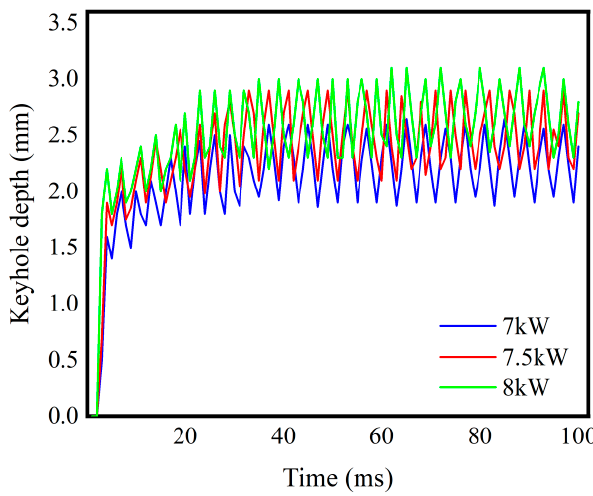
Figure 13. Keyhole depth for different laser powers. Figure 14 shows the variation of the molten pool depth below the keyhole with time for three laser powers. The results show that the depth of the molten pool increases rapidly and